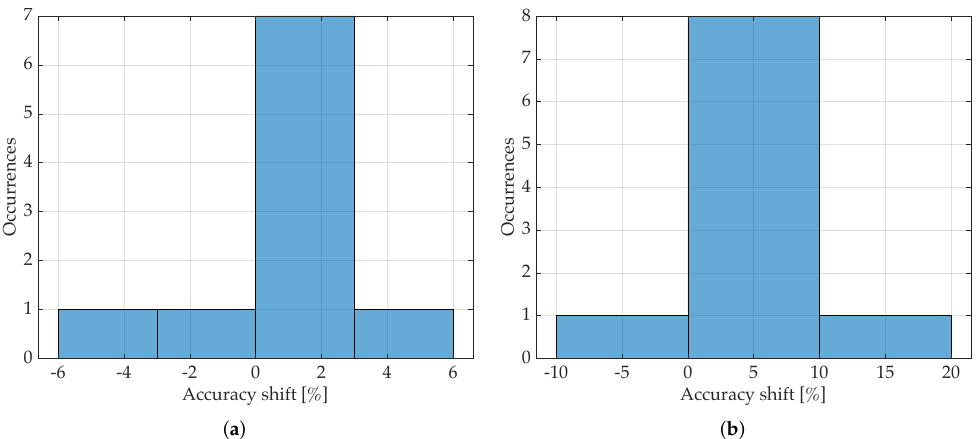
Figure 3. Distribution of the accuracy boosts for paths and cliques across the 10 datasets. A pos- itive shift means that the stratified approach outperforms the non-stratified approach. ( a ) Paths. ( b ) Cliques.